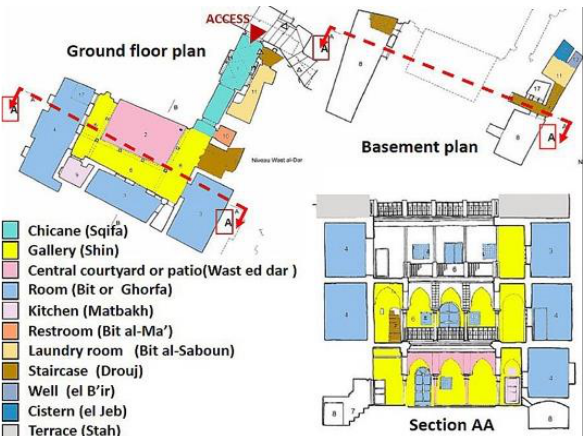
Figure 2. The architectural composition of a house with patio (Missoum, 2003; treated by the